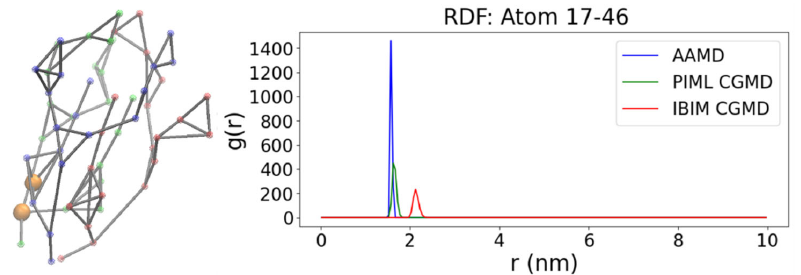
Figure A5. RDF plot between the atoms 17 and 46. Blue—chain A; red—chain B; green—chain C; orange—selected nonbonded atom pair. Spearman’s correlation coefficients: (PIML CGMD) 0.5831; (IBIM CGMD) − 0.0376.